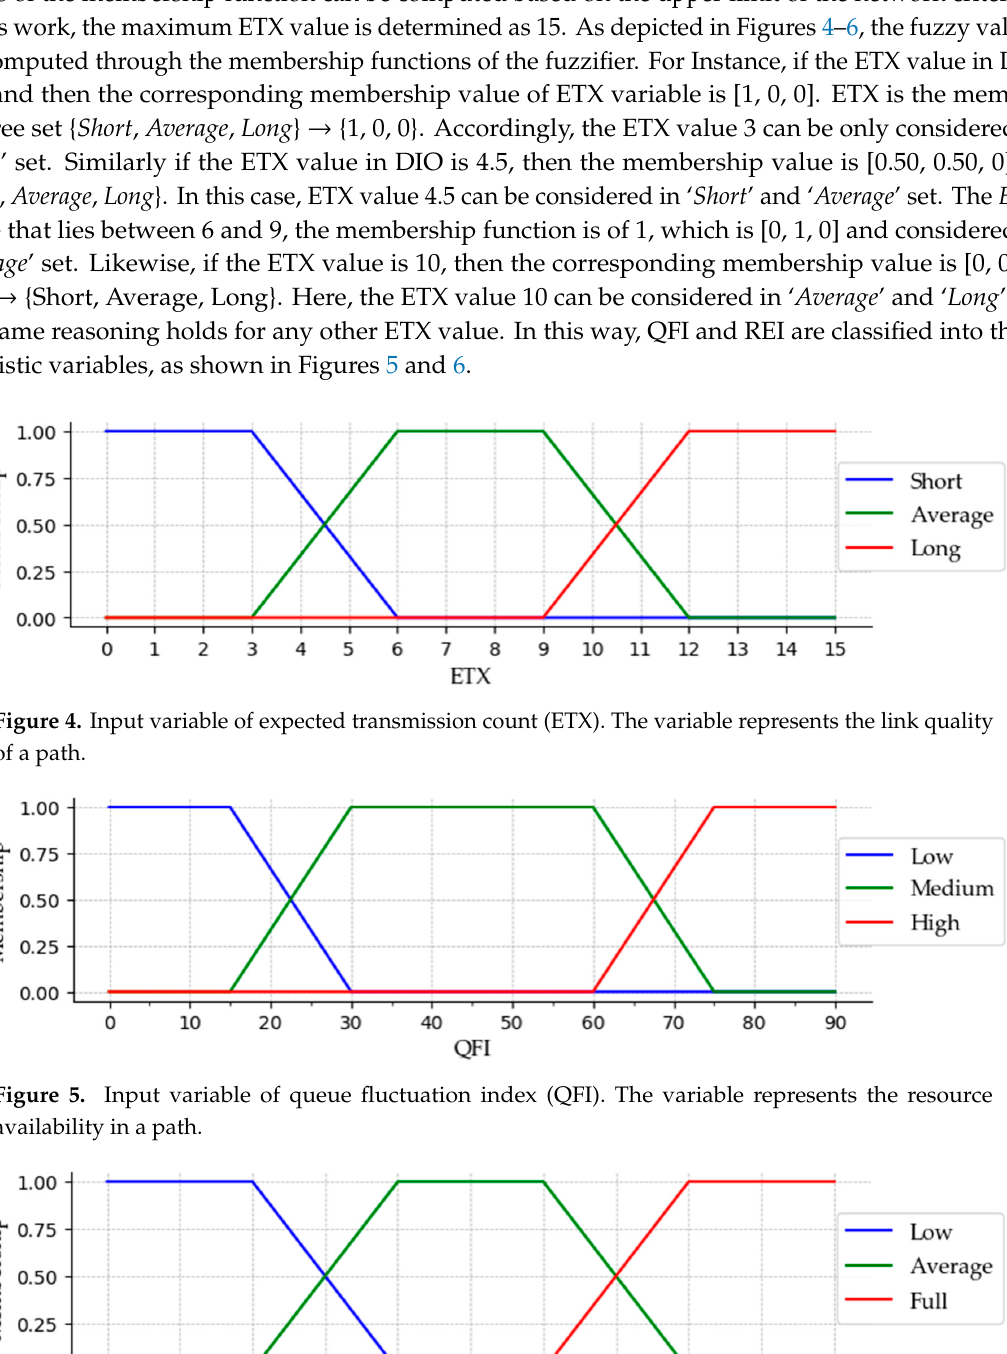
Figure 6. Input variable of residual energy index (REI). The variable represents the energy level of the nodes in a path.